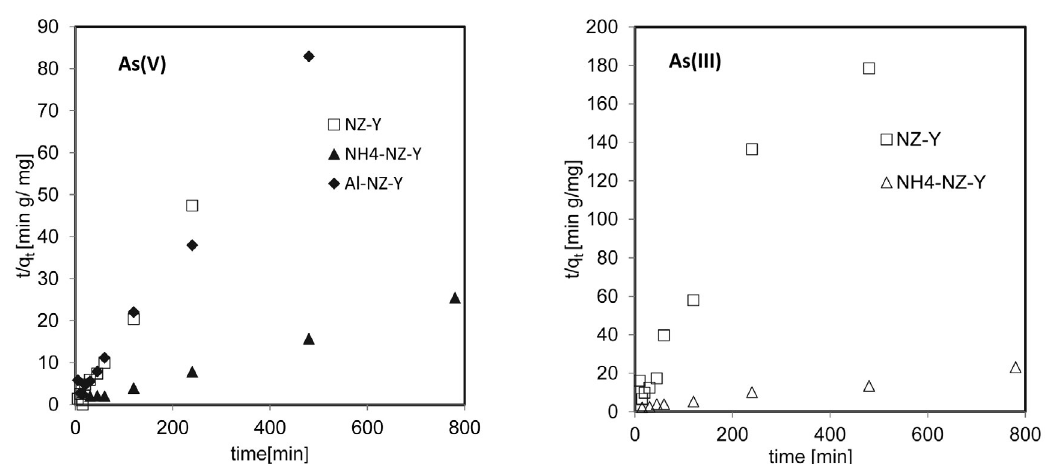
Figure 5. The linear second-order kinetic adsorption data for arsenic by natural and modified